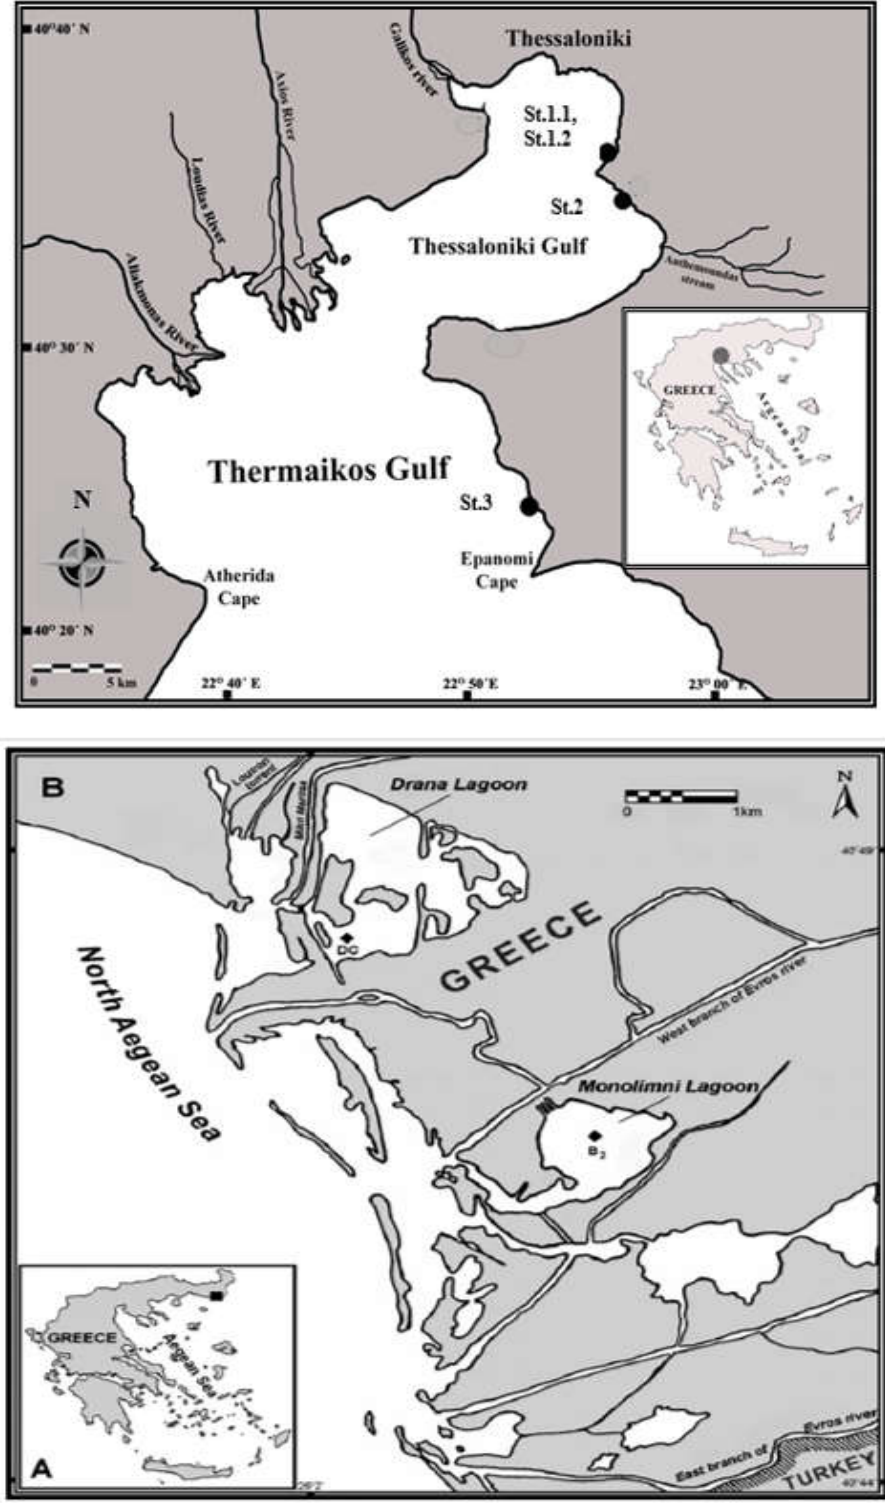
Figure 1. The above map shows Thermaikos Gulf and indicates the sampling stations (i.e., St.1, St.2, St.3). The below maps (( A ): whole map of Greece; ( B ): map of collection region)show Evros Delta and indicate the sampling station (i.e., St.4 Monolimni Lagoon). In above and below maps, the geographical location of the study sites is indicated.